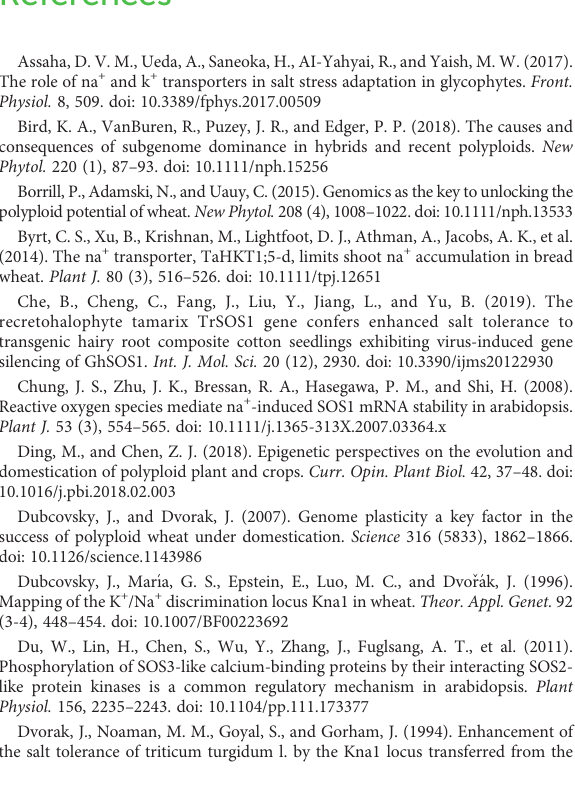
SUPPLEMENTARY FIGURE 5 (A) The 35S:TaSOS1-A , 35S:TaSOS1-B and 35S:TaSOS1-D transgenic lines con fi rmed by RT-PCR. (B) and (C) Comparison of the seed germination of the wild type, the 35S:TaSOS1-A, 35S:TaSOS1-B and 35S:TaSOS1-D plants on MS medium containing 0, or 200 mM NaCl. Seeds harvested on the same day were planted on MS medium. Plates were transferred to a growth chamber after strati fi cation at 4°C for 3 d. Germination rate was determined every 24 h and photographs were taken at 5 d after the transfer.(D)Comparisontheshootsheightof5-week-oldofthewildtype, the 35S:TaSOS1-A , 35S:TaSOS1-B and 35S:TaSOS1-D plants growth